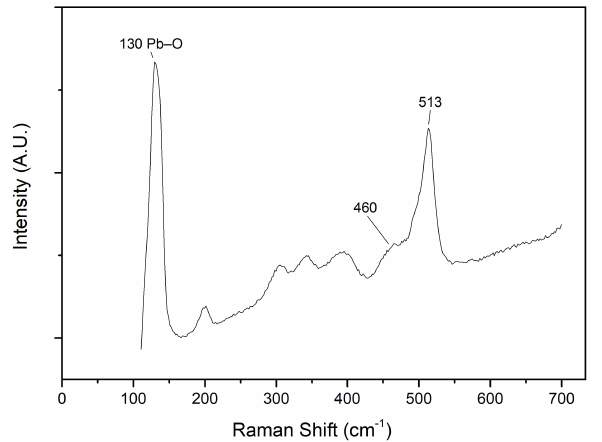
Figure 6. Recorded Raman spectra for a yellow glazed region ( λ excitation = 532